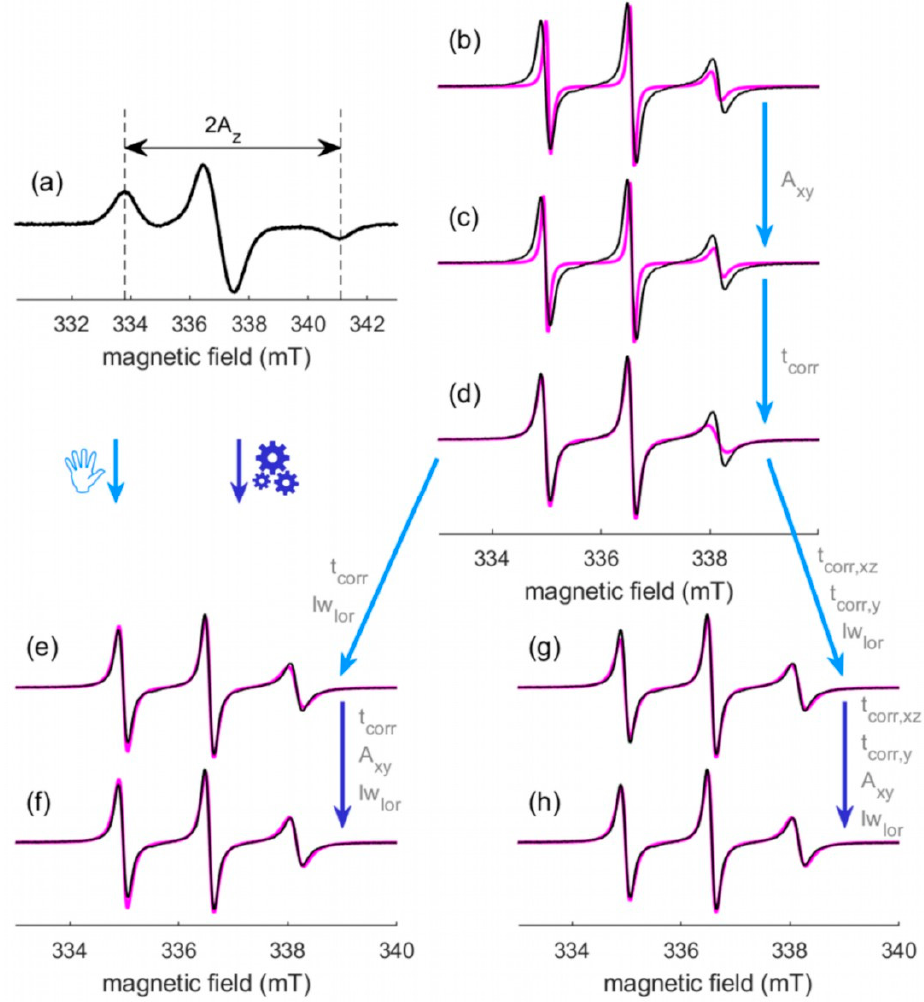
Figure 5. Different steps during the simulation and fitting process for sample 1. ( a ) X-Band spectrum of the frozen solution (115 K) enables to extract 2A z from the position of the two outer lines (A z = 3.64 mT). ( b – h ) Superpositions of the experimental spectrum (black traces) recorded at room temperature with a calibrated magnetic field and the different simulations (magenta traces) of the fitting procedure. The simple arrows indicate the sequence of intermediate simulations. Light and dark blue arrows stand for manual and automatic fitting, respectively. The adjusted parameters are indicated in grey. The parameters of these simulations are given Table 1. Table 1. Variable parameters used to obtain the simulations shown in magenta Figure 5b–h for sam- ple 1. The underlined values indicate the modified parameters from the previous simulation. The other fixed parameters are: A z = 3.64 mT, g x = f(A z ) = 2.0084, g y = 2.0061 and g z = 2.0022 at 9.45 GHz.